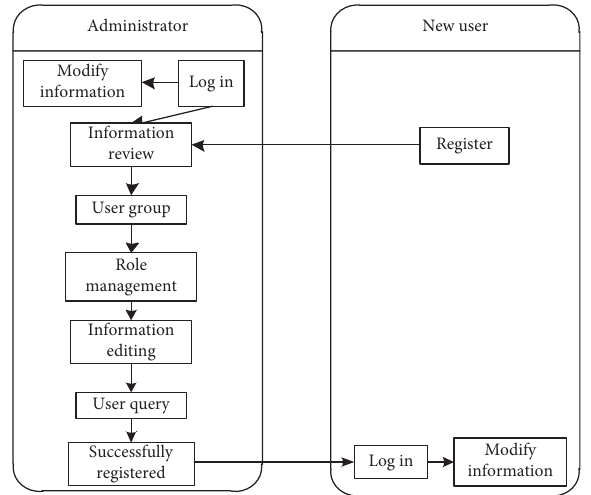
Figure 5: User management business flowchart.